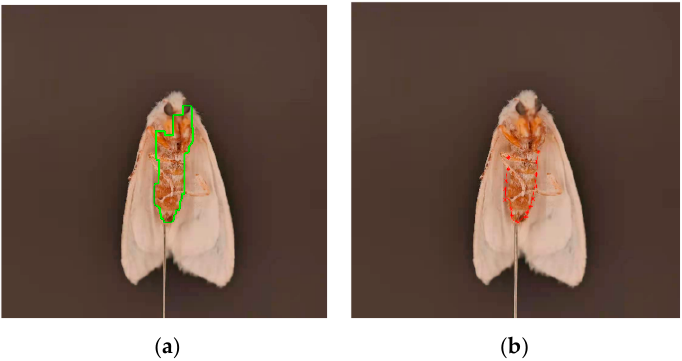
Figure 10. Abdominal contour curve fitting of H. cunea : ( a ) abdominal edge extraction and ( b ) ab- dominal edge fitting.